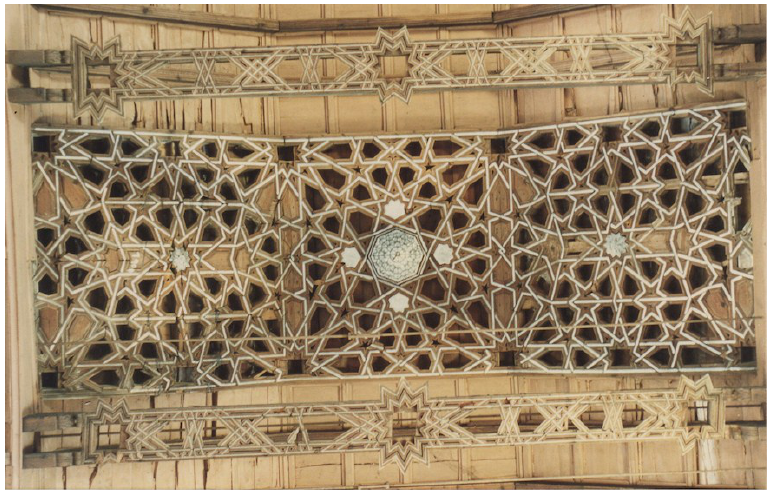
Figure 10. Detail of the wooden ceiling. Parish church of Santa Maria del Soterraño. Aguilar de la Frontera (Cordoba). Photo took by